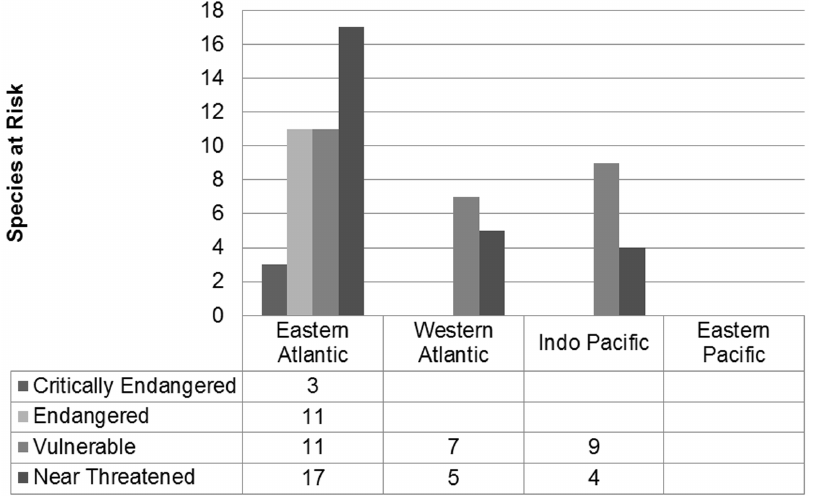
Figure 4. Number of Conus species at risk by ocean basin. The number of species at risk by ocean basin for each threatened category. There are no species at risk in the Eastern Pacific.